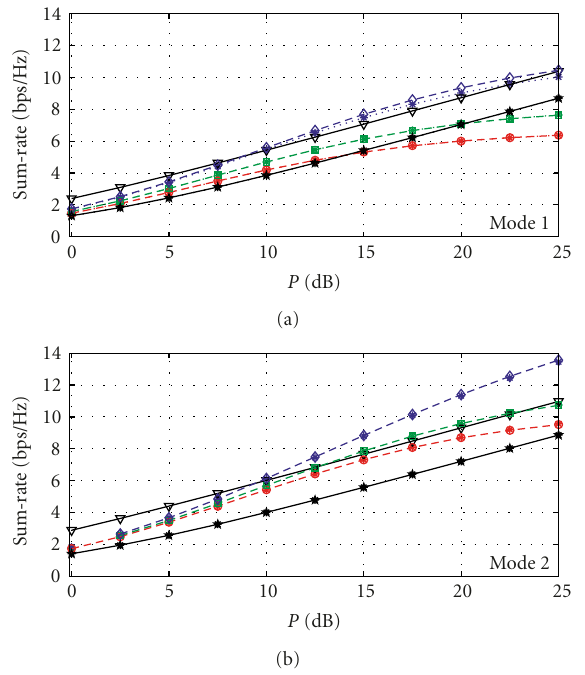
Figure 5: Virtual MIMO system sum-rate for two-antenna mode 1 ( K = 16) and mode 2 ( K = 64) in the presence of Rayleigh fading, constant Tx power, and SIR CQI. Solid curves with stars (“ (cid:3) ”) refer to TDMA-RR, while solid lines with triangles (“ (cid:5) ”) correspond to TDMA-BUS. Dashed curves with circles (“ ◦ ”), dashed curves with squares (“ (cid:6) ”) and dashed curves with diamonds (“ (cid:14) ”) refer to pure ORR (ZFBF-PF throughput lower bound), ORR-SIR and ZFBF- SUS (ZFBF-PF throughput upper bound), respectively. In all cases, point values (“ ∗ ”) were simulated to verify the analytical results.